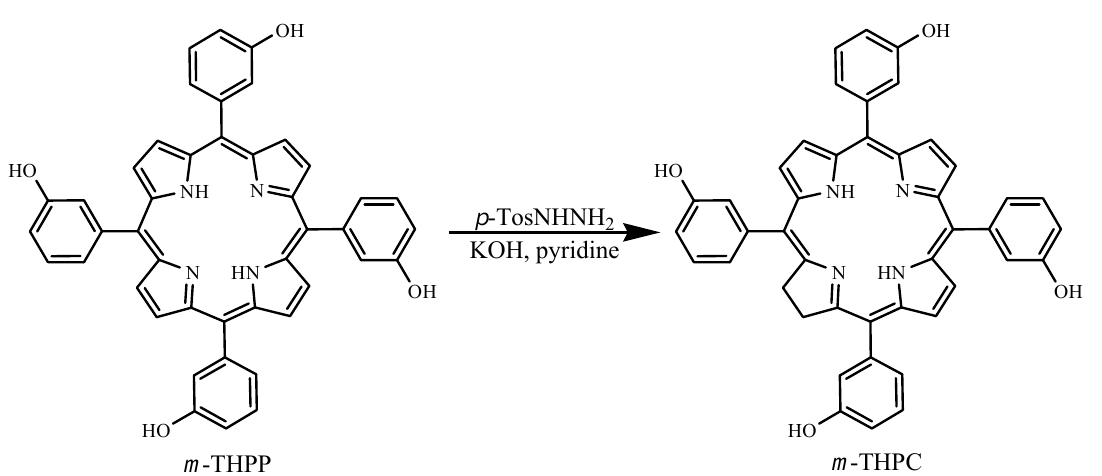
Figure 11. Formation of meta -tetra(hydroxyphenyl)chlorin ( m-THPC) by tosylhydrazine reduction of meta -tetra(hydroxyphenyl)porphyrin ( m